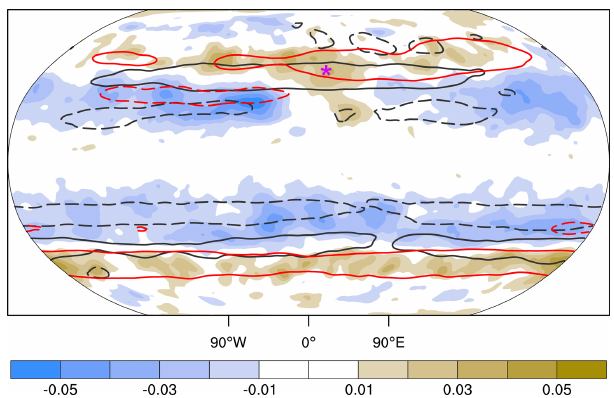
Figure 4. Change in external baroclinic conversion efficiency (shad- ing), eddy total energy (red; ± 25Jkg), and background baroclinic- ity (black contours; dashed indicate negative and solid positive val- ues; units of ± 1.5 × 10 − 6 s − 1 ). All fields are mass-weighted verti- cally averaged between 1000–200hPa. The key region of enhanced conversion efficiency downstream of the SST front is marked by an